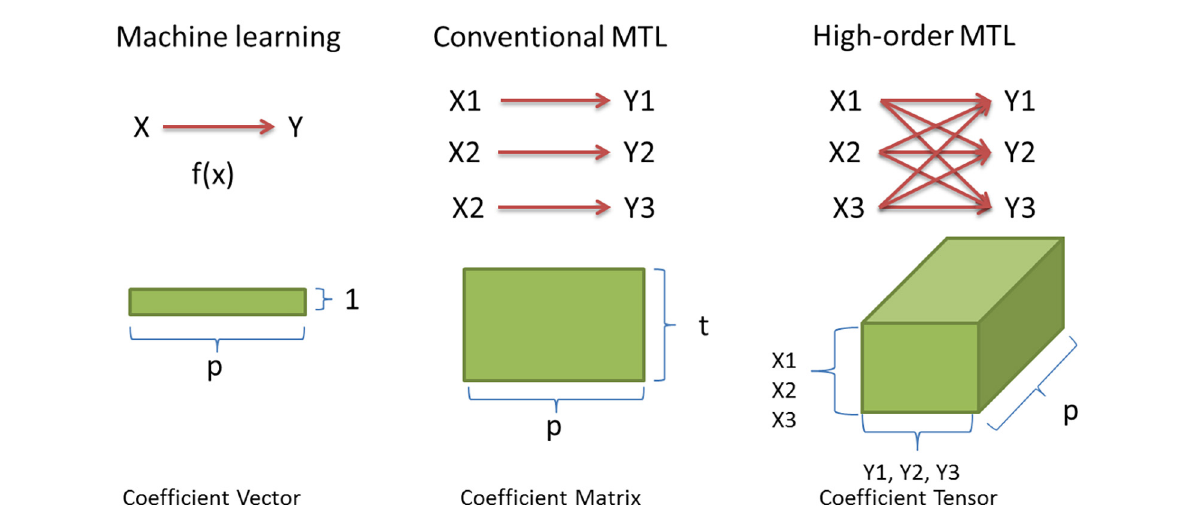
FIGURE3 From machine learning (ML) to High-order MTL. In ML, one functional mapping links the predictors and the outcome, and the coefficients are represented as a vector. In conventional MTL, similar to ML, multiple “one-to-one” mappings link the predictor and outcome domain, where the mappings are not crossed among tasks. The resulting coefficients are represented as a matrix. In high-order MTL, highly complex multi-modality is accounted for by “multiple-to-multiple” mappings to connect the predictor with the outcome domain. The coefficients are represented as a tensor.